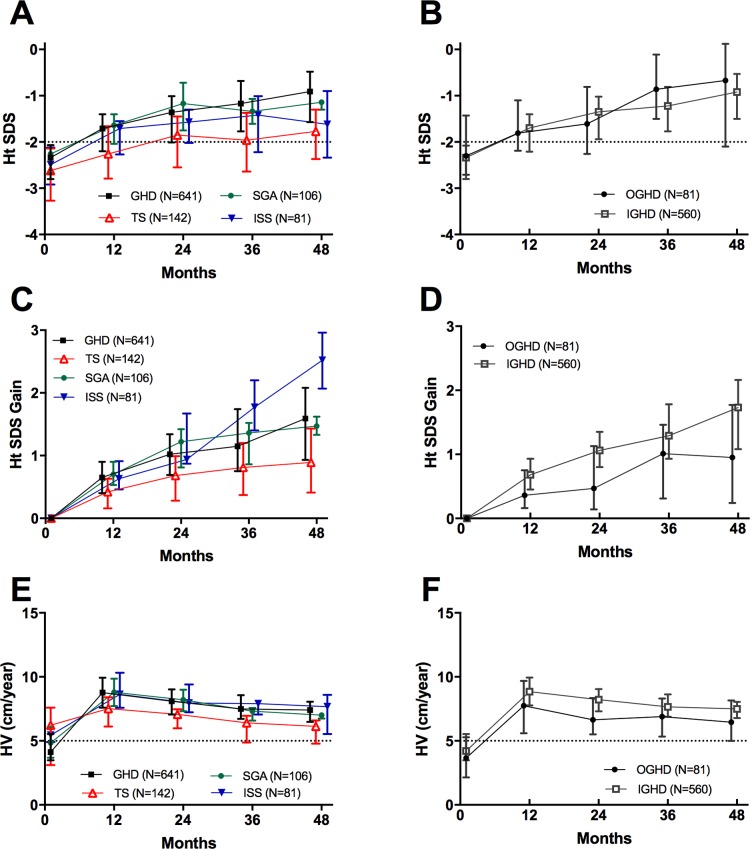
Auxological measurements through the fourth year.The symbols indicate the median values and the vertical bars indicate interquartile range. IGHD was confirmed by at least two GH stimulation tests (peak responses from both tests <10 ng/mL).